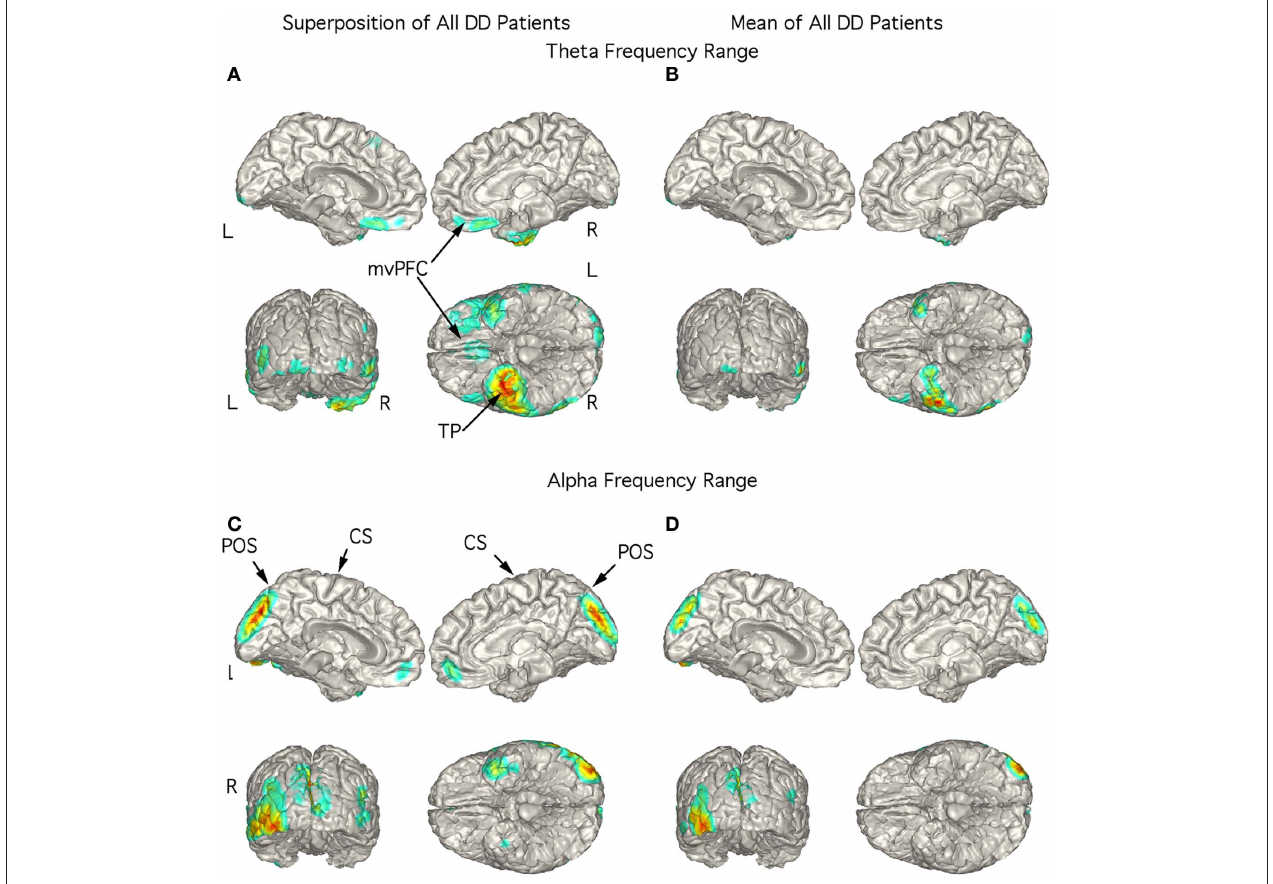
FiGure 5 | Localization of theta and alpha band current sources in depressed patients. (A) Superposition of theta range independent components (ICs) for depressed patients. Note that activity is strongest to right temporal pole. (B) Mean of localizations in (A) show strong activity in right temporal pole.